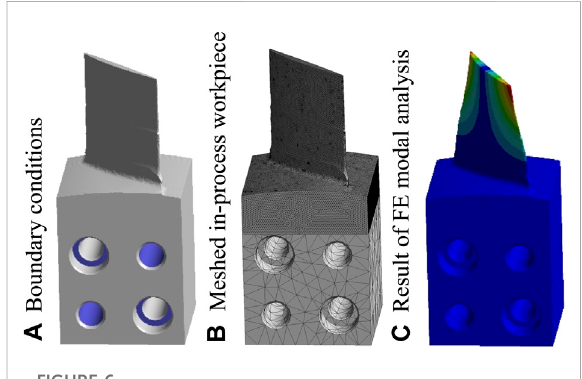
FIGURE 7 FE results in form of the torsional mode for block 2 in CAM environment. (A ) 50 simulated positions, (B) vertical interpolation, (C) horizontal